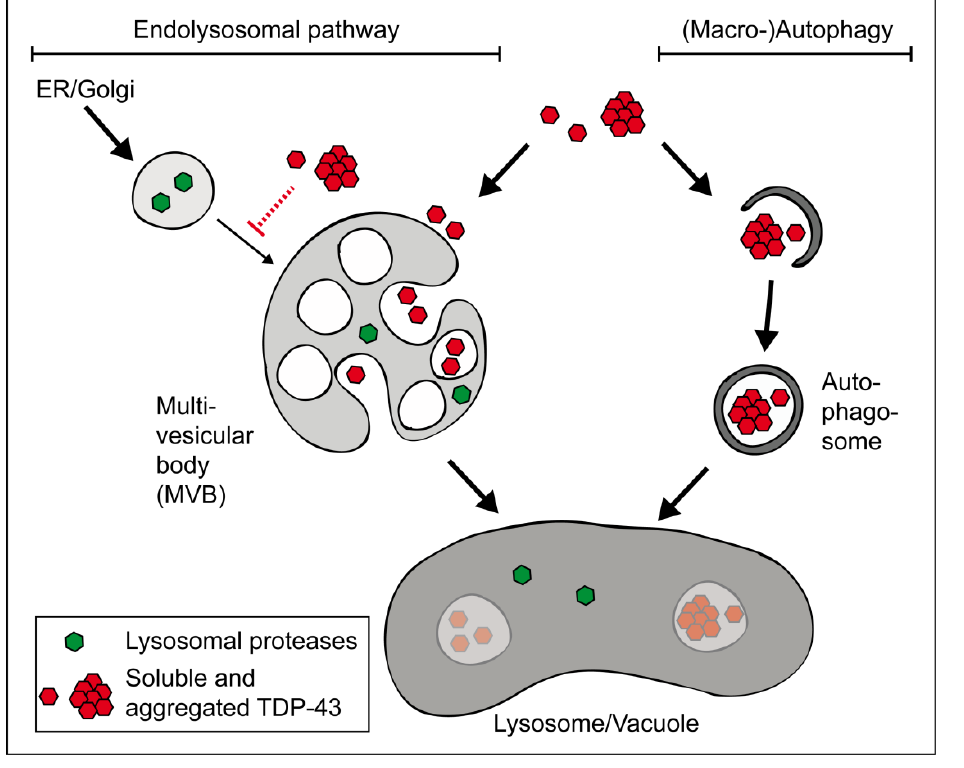
FIGURE 1: Lysosomal deg- radation of TDP-43. The lysosome (or the yeast vacuole) contains a num-